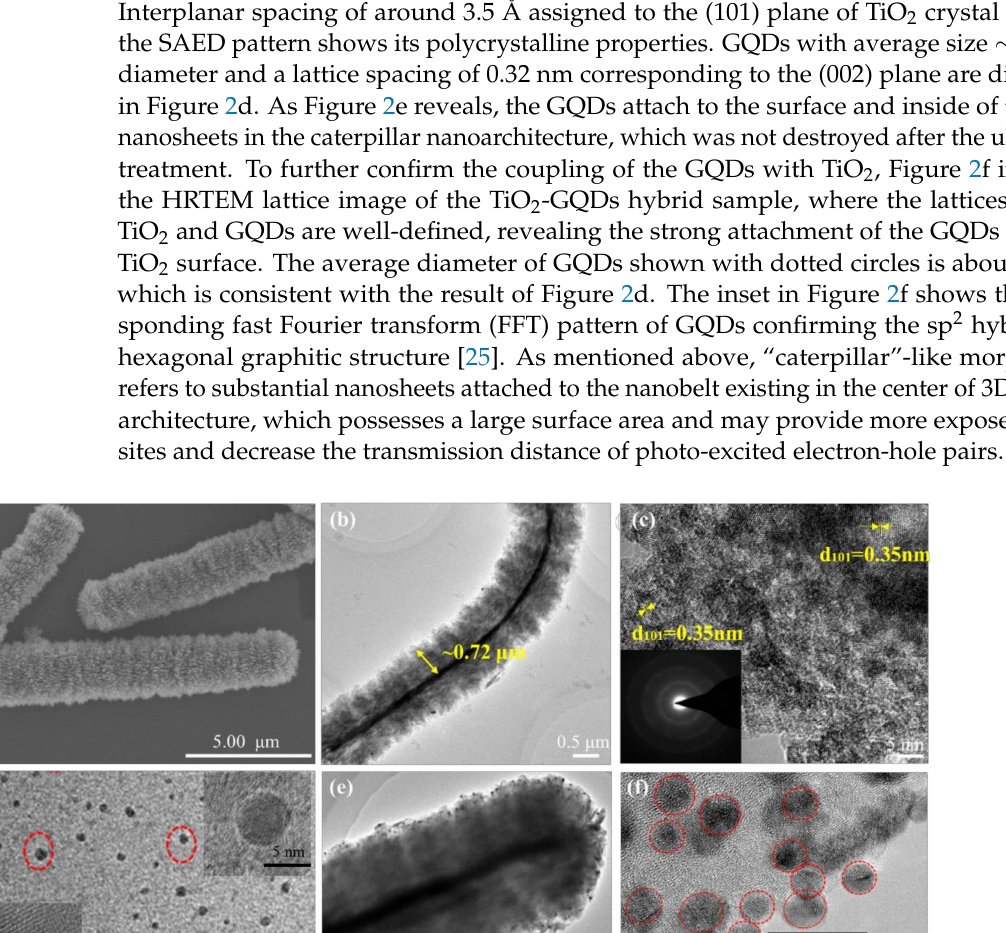
2 -GQDs caterpillar hybrid. The